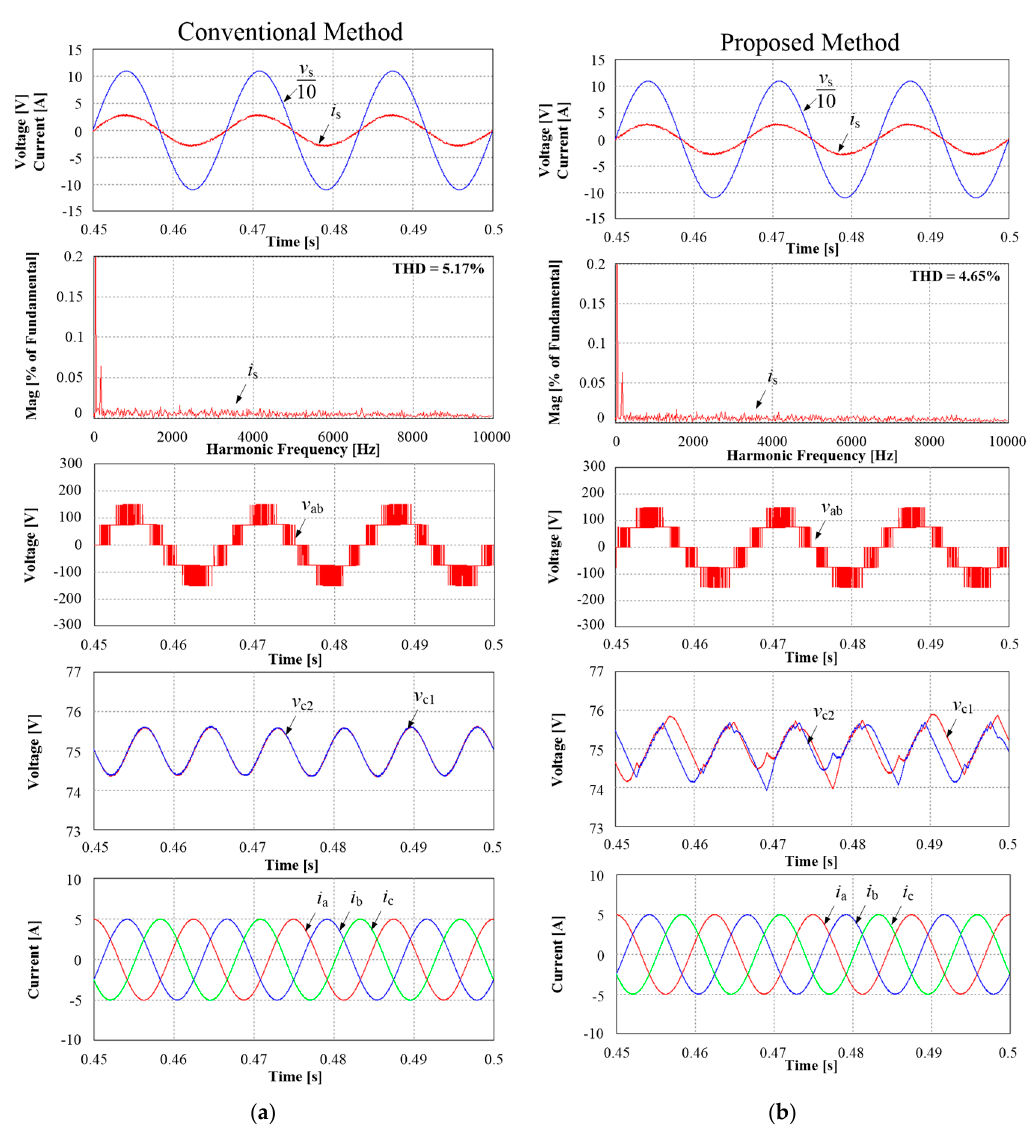
Figure 18. Simulation results with the three-phase voltage source inverter as a nonlinear load: ac source current ( i s ), frequency spectrum of input current ( i s ), line to line source voltages ( v ab ), capacitor voltages ( v c1, v c2 ), and three-phase load currents of the voltage source inverter (from top to bottom) obtained by ( a ) the conventional method ( b ) the proposed methods.